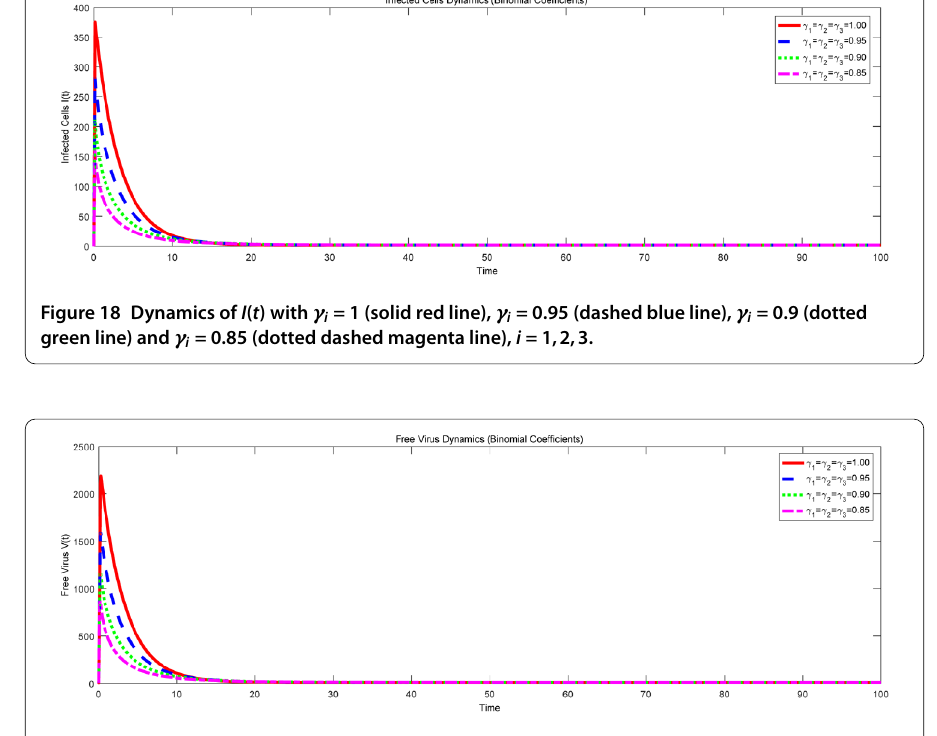
Figure 19 Dynamics of V ( t ) with γ i = 1 (solid red line), γ i = 0.95 (dashed blue line), γ i = 0.9 (dotted green line) and γ i = 0.85 (dotted dashed magenta line), i =